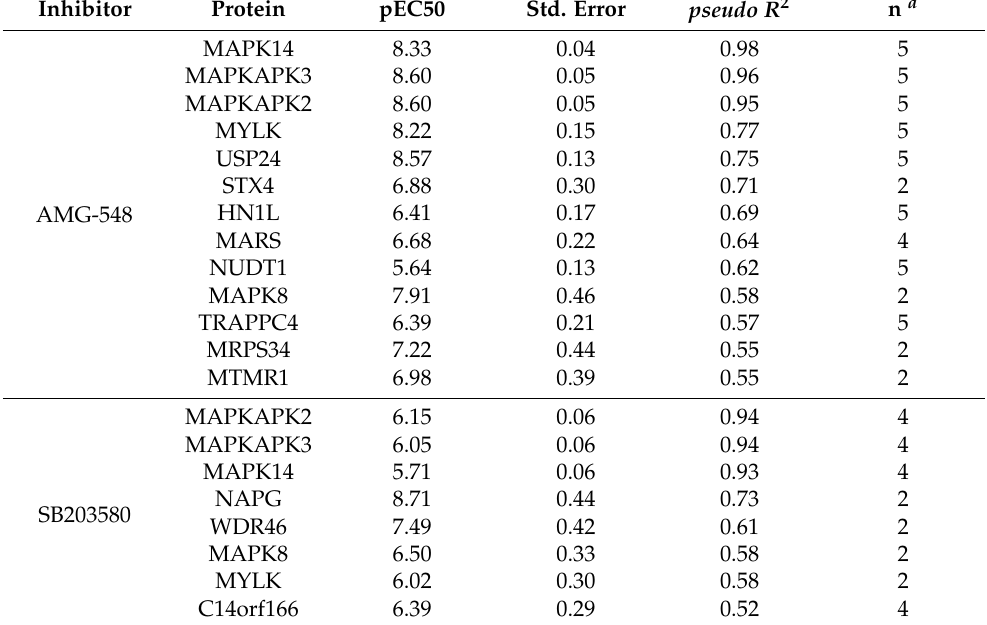
Table 3. Data of the TPP-CCR experiments performed using AMG-548 and SB203580 (see Supple- mentary Table S3 for ERK 11e) for the proteins filtered for acceptable stabilizing dose–response characteristics and ordered by pseudo R 2 (a measure for the